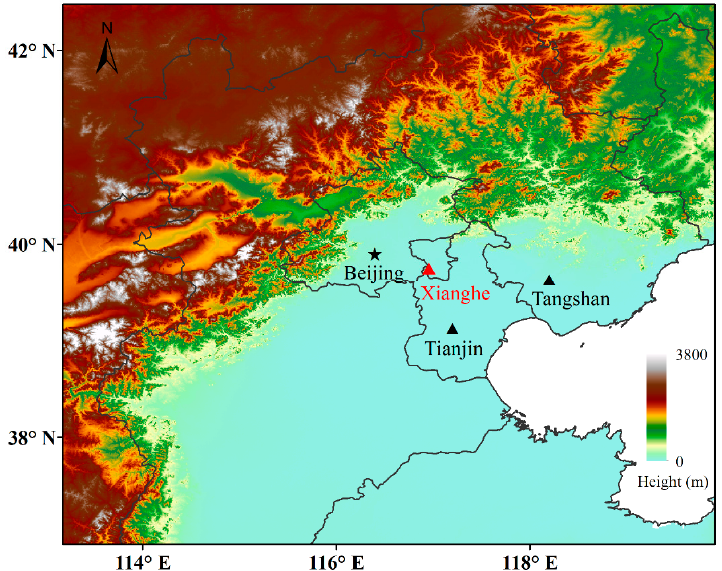
Figure 1. Terrain elevation and location of the Xianghe Station (red triangle) and other major cities.